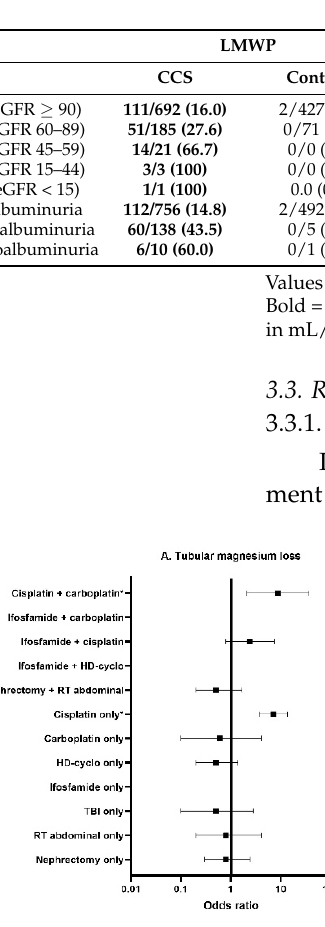
Table 5. Relation between glomerular function and tubular outcomes in childhood cancer survivors and controls.